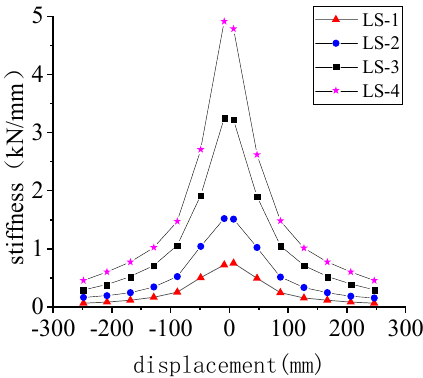
Figure 23. Stiffness degradation curve of LS specimens.